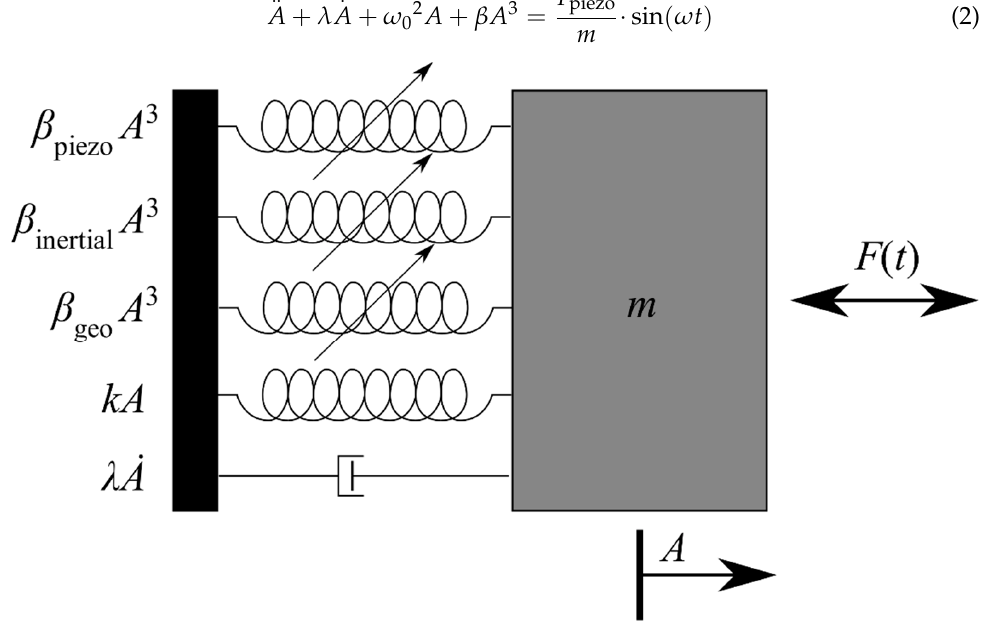
Figure 1. Schematic picture of a piezoelectrically actuated micro-oscillator with force F ( t ) and mass m. The moving mass is attached to a fixed anchorage via a linear damper and four springs representing the linear and the three nonlinear restoring forces.